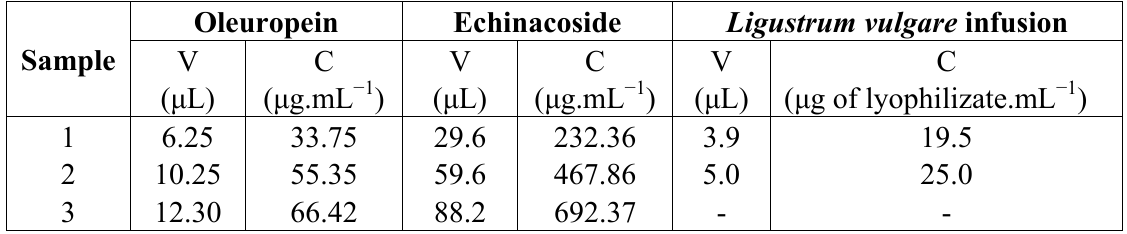
Table 2. Concentrations of used inhibitors of LOX.